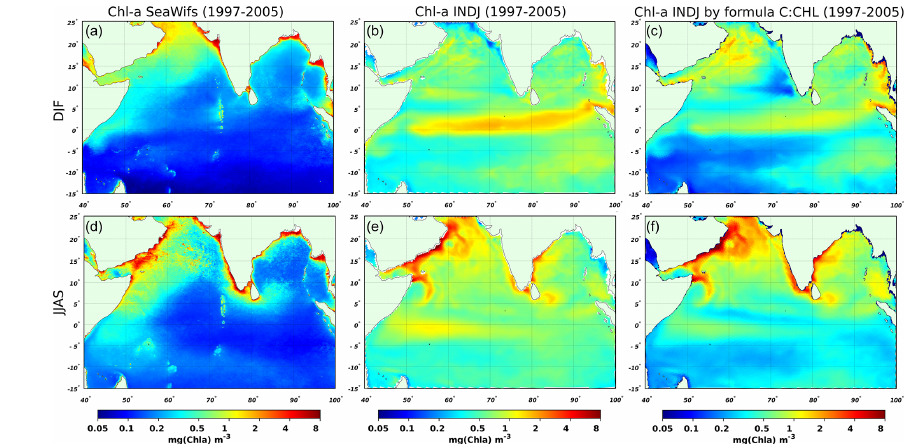
Figure 3. Distribution of surface chlorophyll a concentration obtained by the SeaWiFS satellite data (NASA Goddard Space Flight Center, 2021a; a , d ), model using a fixed C : Chl ratio ( b , e ), and using a varying C : Chl ratio as in Anderson et al. (2007) ( c , f ), for winter ( a – c ) and monsoon ( d – f ) climatic